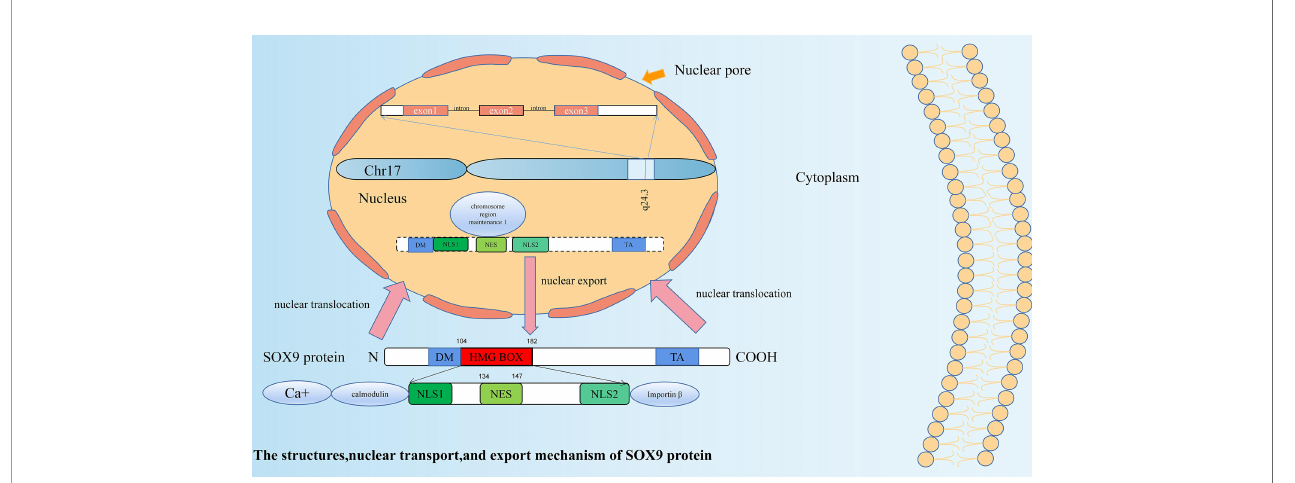
FIGURE 1 | The structure, nuclear transport, and export mechanism of SOX9 protein. SOX9 has three exons, two introns and an open reading frame (ORF). SOX9 protein is a polypeptide containing 509 amino acids. A total of 79 amino acids from positions 104 to 182 of the polypeptide chain constitute the HMG box. In addition to the HMG domain, SOX9 has two other functional domains: a dimerization domain (DIM) and a transactivation domain (TA). Its HMG domain contains two nuclear localization signal (NLS) sequences and one leucine-rich nuclear export signal (NES) sequence. NLS located at the N-terminus promotes nuclear translocation of SOX9 by binding to calmodulin activated by calcium ions. NLS located at the C-terminus interacts with importin b to form a complex, which then, via the RAN GTP-dependent pathway, mediates SOX9 to complete nuclear transport through the nuclear pore. The NES sequence located between the two NLS sequences can interact with chromosome region maintenance 1 to mediate the nuclear export of SOX9